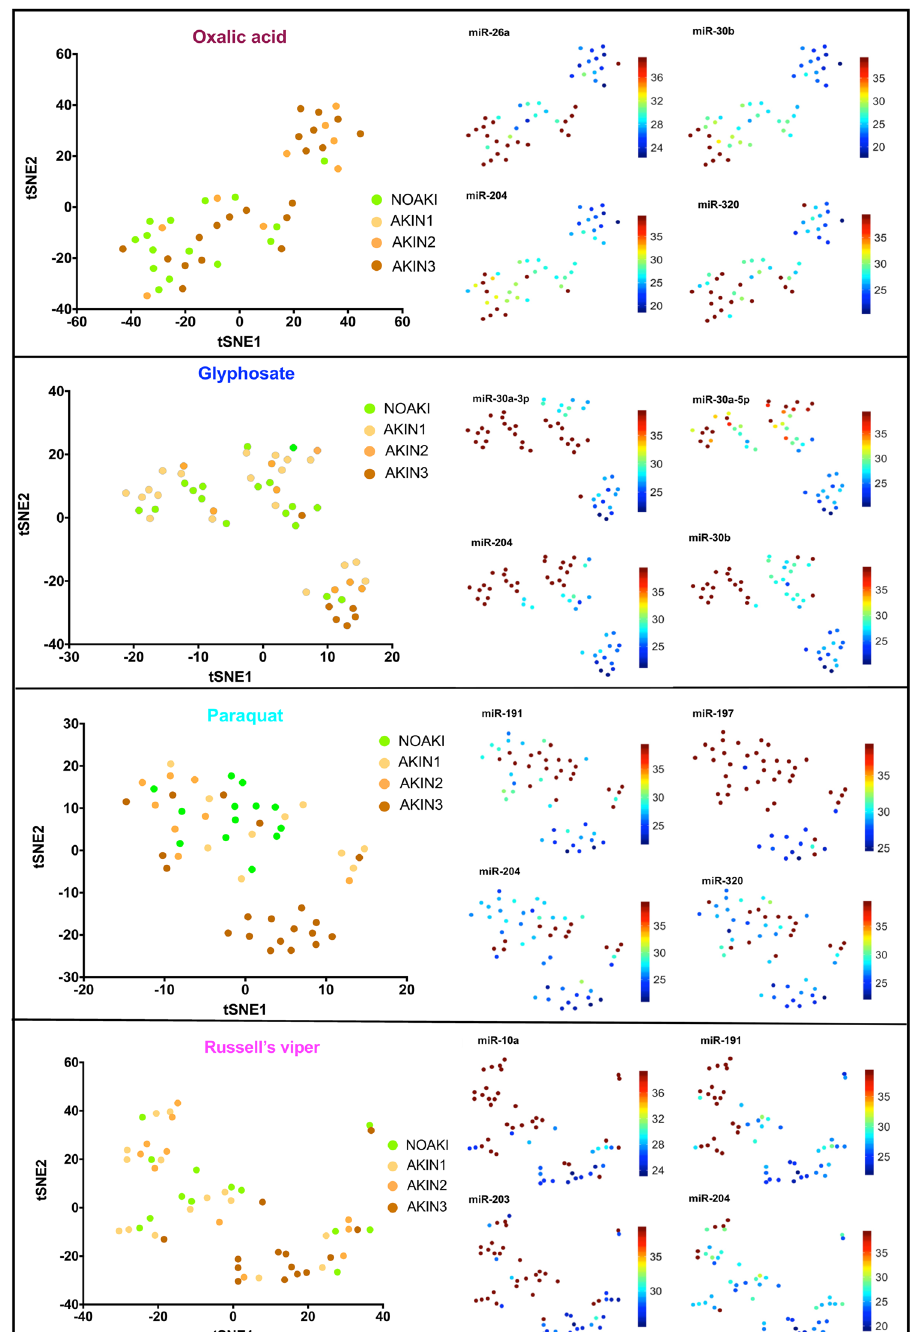
Figure 2. tSNE plots show the clusters of individual microRNAs with NOAKI, AKIN1, AKIN2 and AKIN3 caused by different poisons. Left panels show plots of the non-linear tSNE map of samples in validation cohort using each specific set of differentially expressed microRNAs for different poisons (oxalic acid, glyphosate, paraquat) and Russell’s viper bite, (Supplementary Table 3). Plots were generated using 4-dimensional principal component space into two dimensions showing tSNE analysis. Each point represents a single sample. The right panel shows the expression of the top four most significantly altered microRNAs for each poison presented as individual tSNE-projections. Blue to red presented in the color bar indicate high to low microRNA expression (data shown in normalized Ct values, therefore a lower value represents a higher expression)